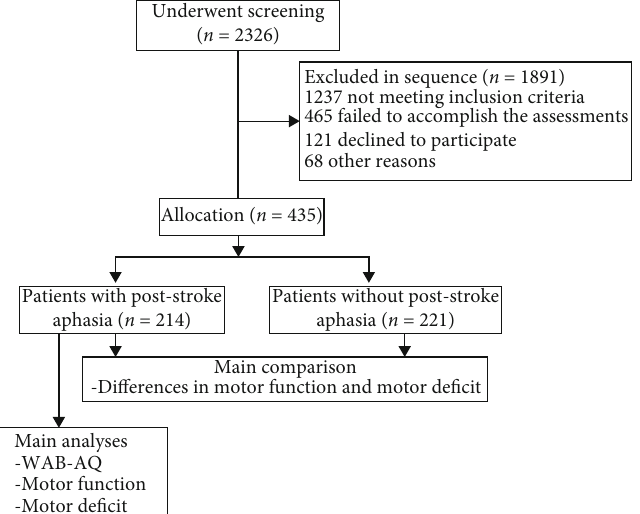
Figure 1: Flow chart of the study sample and procedures of the comparison and analyses. WAB-AQ indicates the Western Aphasia Battery- Aphasia Quotient; FMA-UE indicates the Fugl-Meyer assessment for the upper extremity; ARAT indicates the action research and action